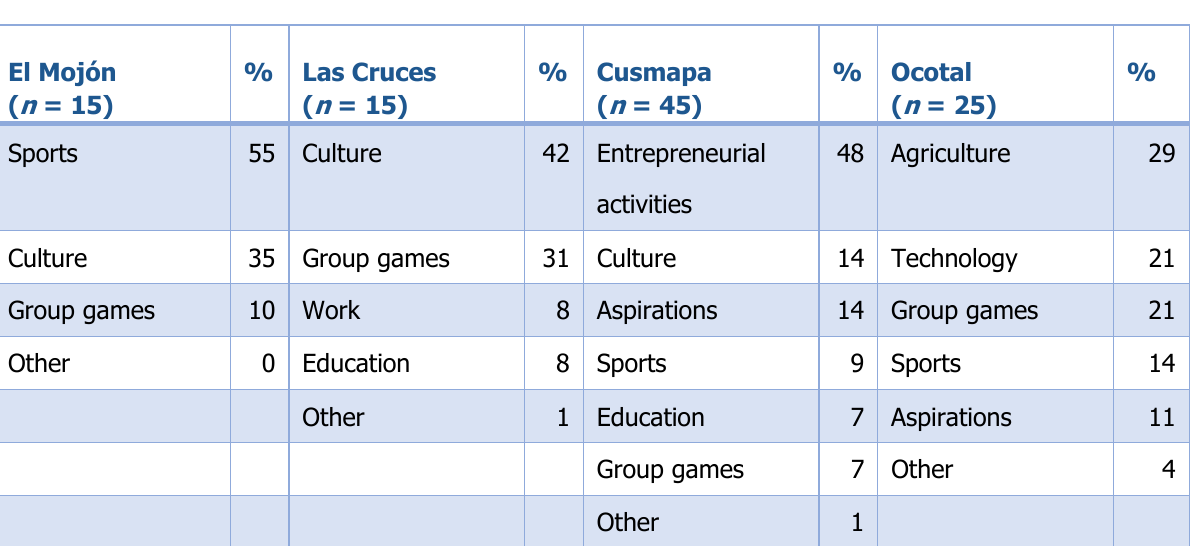
Table 5. Percentage of Responses by Each Community for the Statement: “Just for fun we